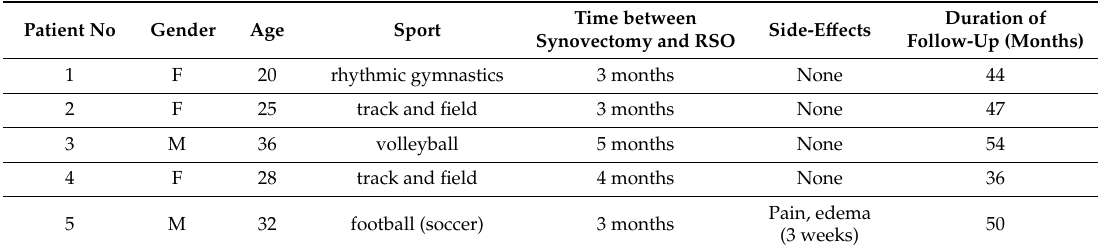
Table 1. Characteristics of the studied patients.